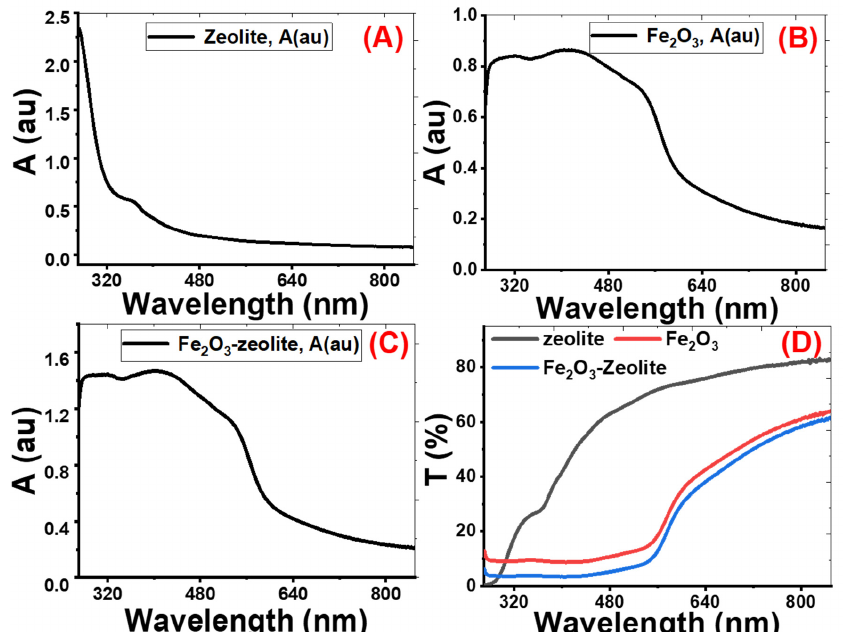
Figure 5. Absorbance (A%) for zeolite ( A ), Fe 2 O 3 ( B ), and Fe 2 O 3 /zeolite ( C ), and transmittance (T%) for all samples ( D ).